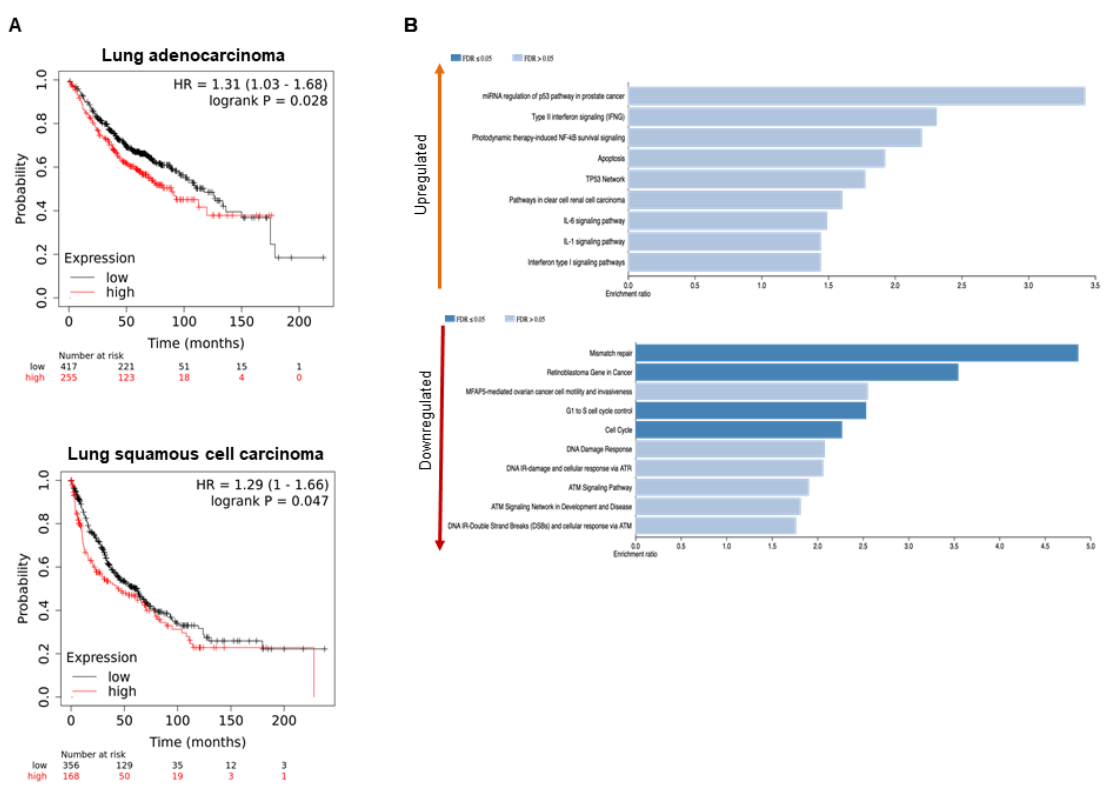
Figure 1. Bioinformatics analyses to determine the prognostic value of PRMT5 and its major functional pathways in lung cancer ( A ) Kaplan–Meier survival analysis of overall survival revealed that high PRMT5 expression was significantly associated with worse overall survival (OS) in both lung cancer subtypes of adenocarcinoma and squamous cell carcinoma. ( B ) Using a publicly available dataset (GSE56757), the differentially expressed genes between PRMT5-silenced and control A549 lung cancer cells were identified and entered into WebGestalt tool to determine the top upregulated and downregulated functional pathways.